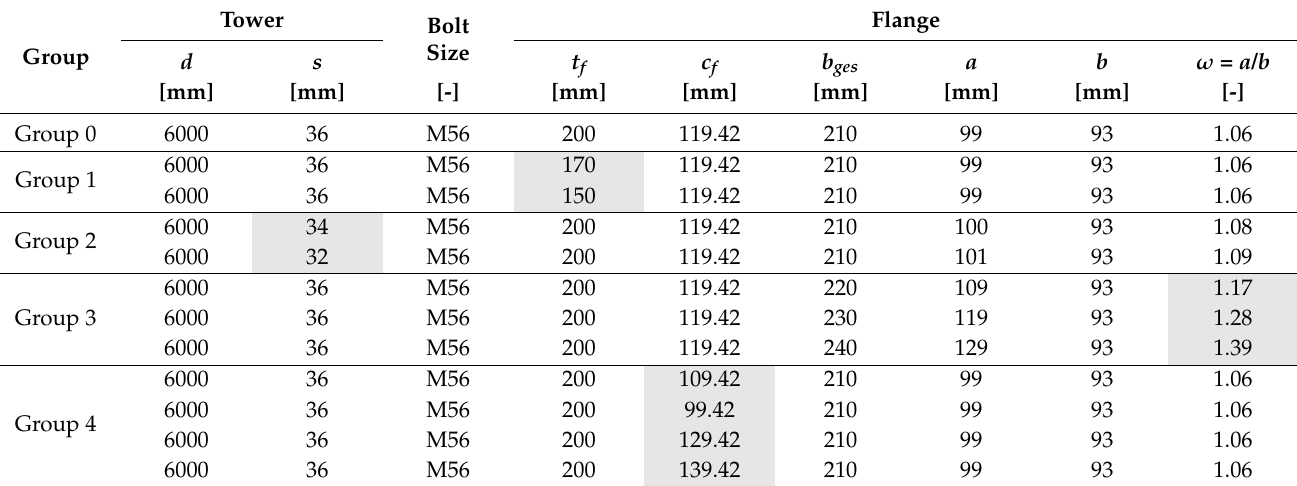
Table 4. Geometrical parameters of the investigated flange